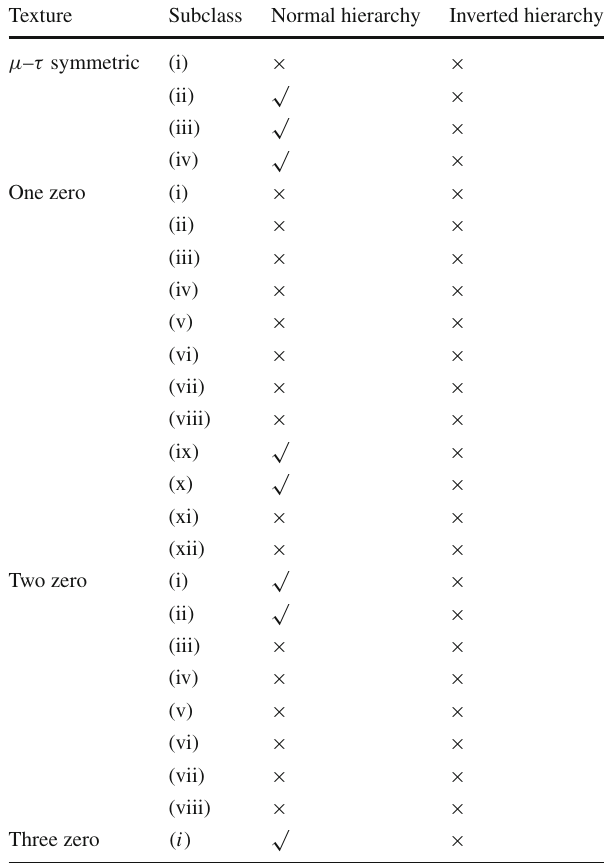
Table 3 Table showing allowed and disallowed texture subclasses which have been analysed numerically. Here ( cases and ( × ) indicates disallowed